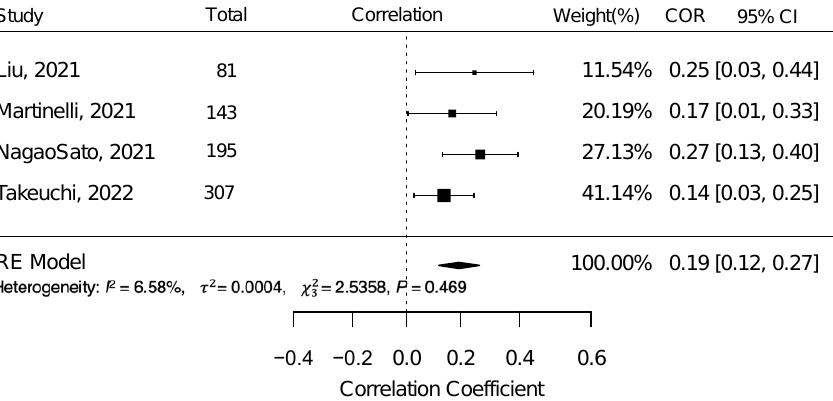
Figure 3. Meta-analysis results for the four studies– Liu et al. (2021) [50], Martinelli et al. (2021) [51], Nagao Sato et al. (2021) [52], and Takeuchi et al. (2022) [53], to examine the correlation between reflection spectroscopy-based skin carotenoid score with fruit and vegetable consumption in children ( Abbreviation: COR = Correlation, CI = Confidence Interval).